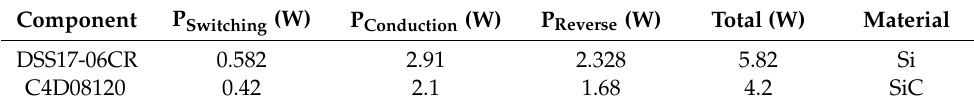
Table 12. Power losses distribution in diode D 1